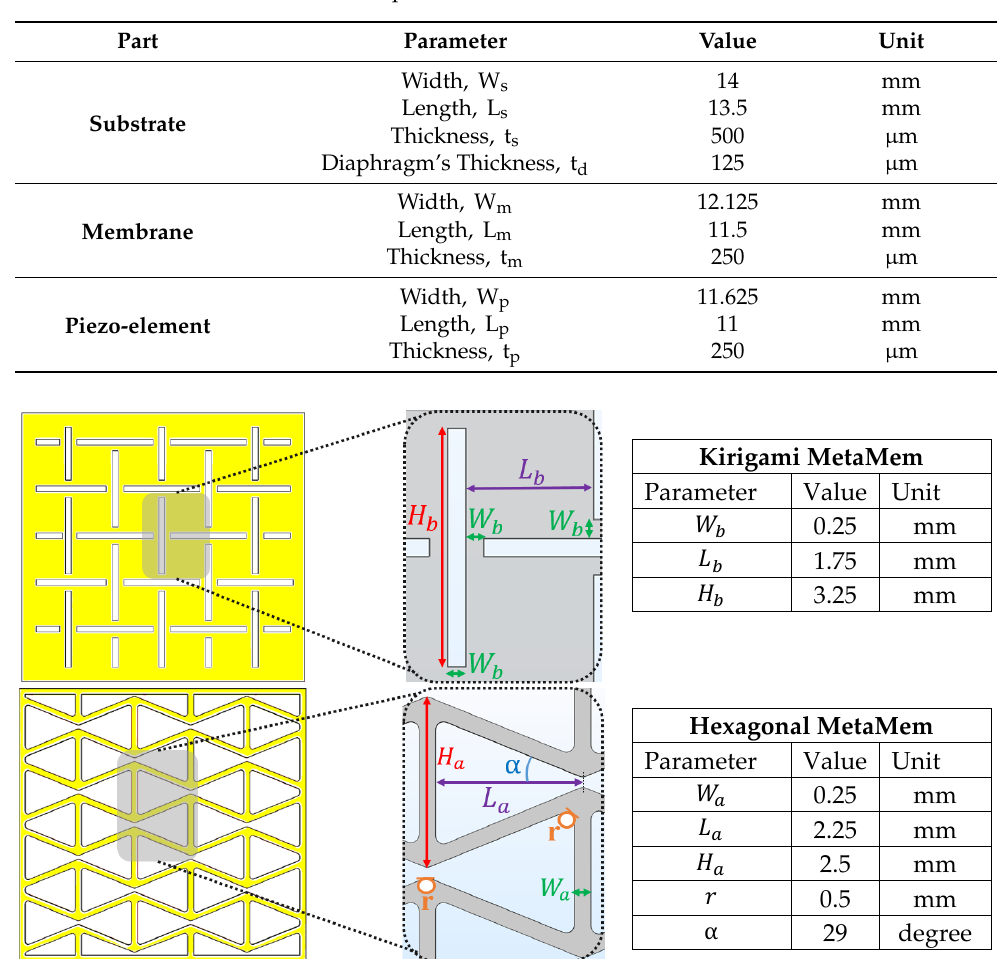
Figure 2. Scheme of the CPS model.